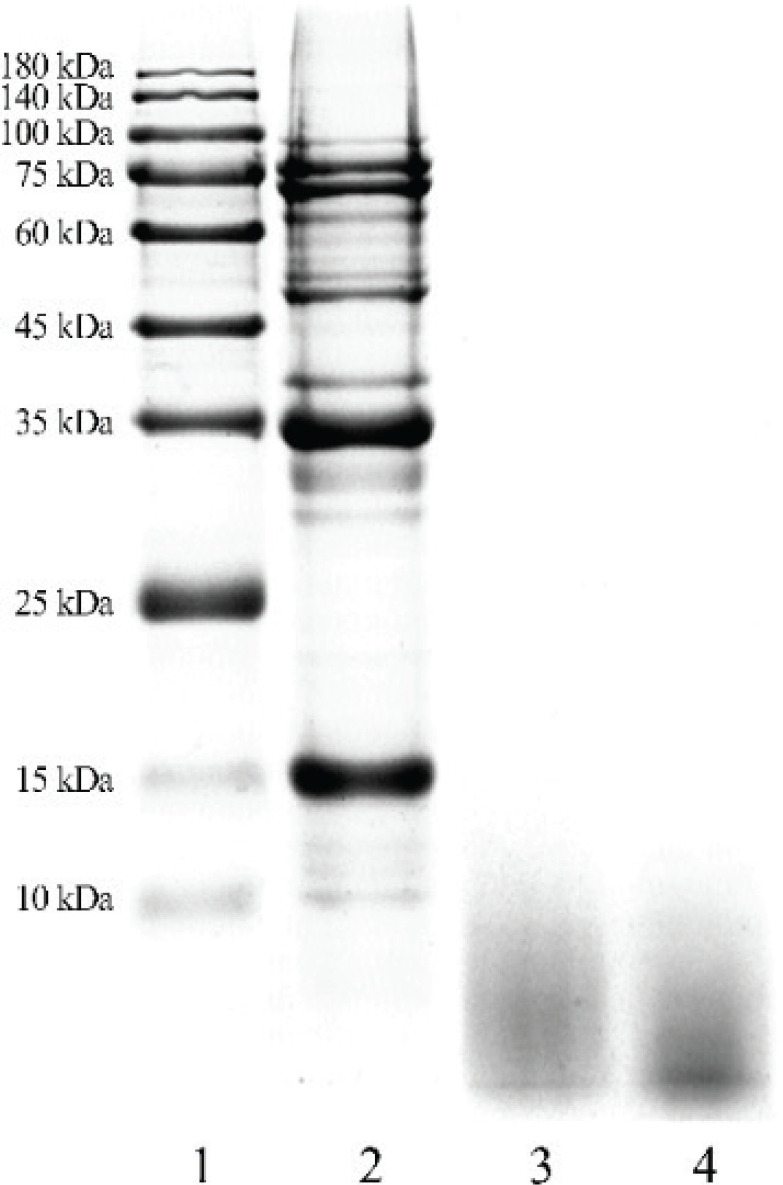
SDS-PAGE visualization of SPI hydrolysis pattern. The amount of protein loaded in each lane is ~20 μg. Lanes: 1, pre-stained protein marker; 2, SPI; 3, enzymatic hydrolysate; 4, SPP.